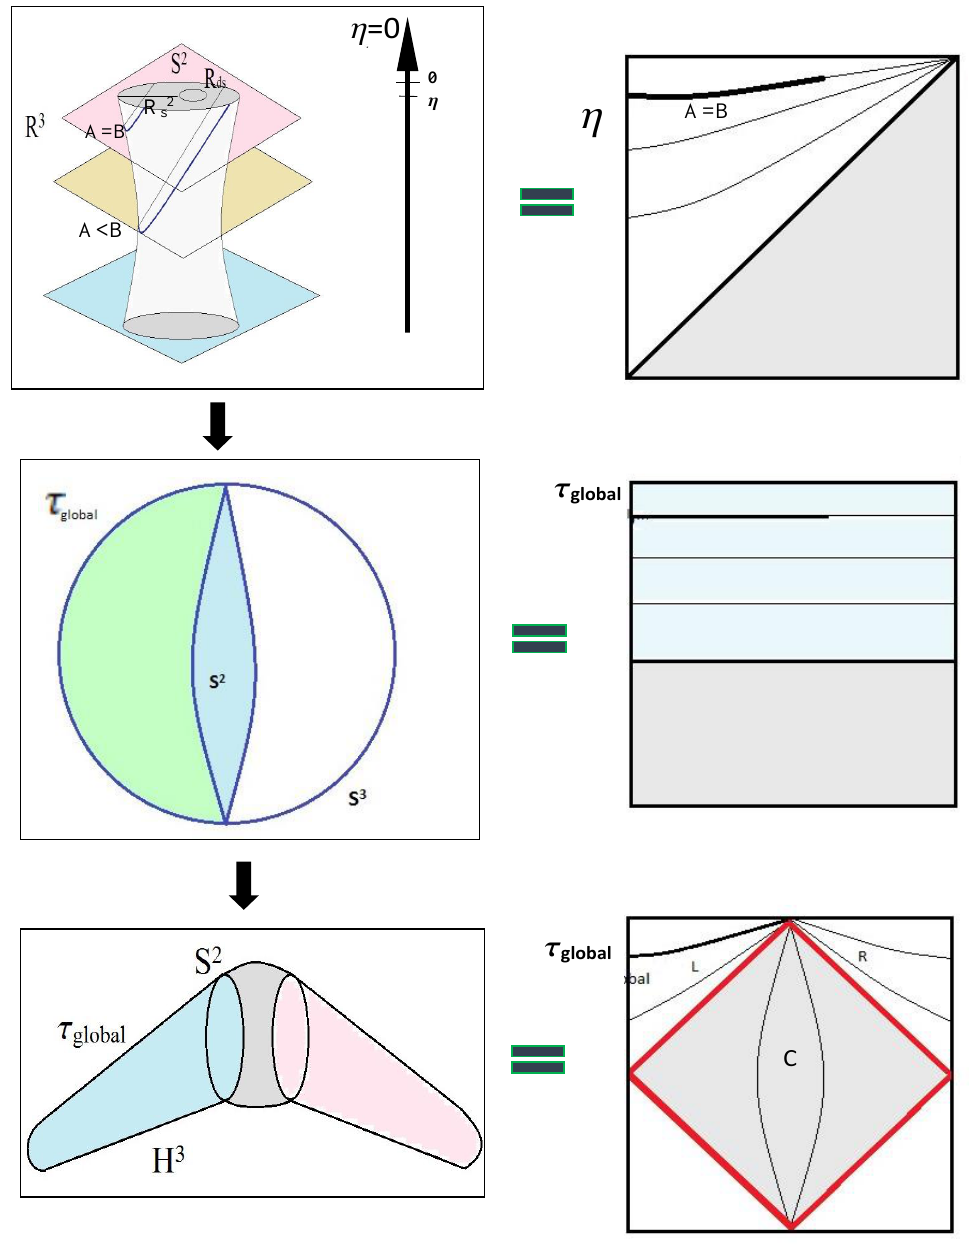
Figure 2. Schematic diagram for the geometrical construction and underlying symmetries of the bipartite quantum field theoretic system of de Sitter hyperbolic open chart. Corresponding Penrose diagrams are also drawn for